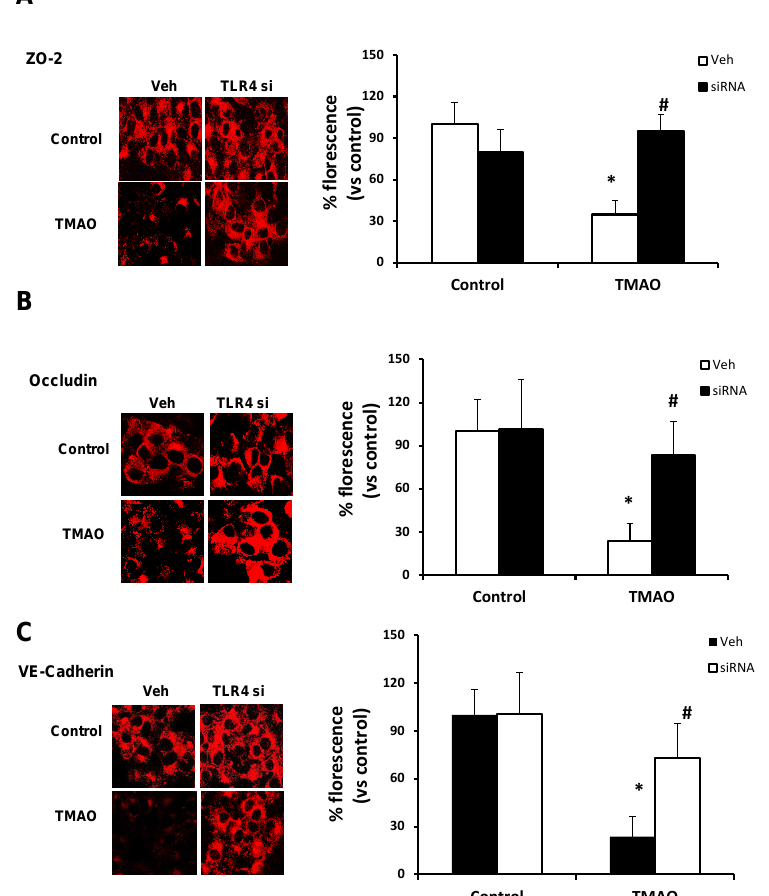
Figure 8. E ff ects of TLR4 inhibition by TLR4 siRNA on TMAO-induced tight junction proteins ZO-2, Occludin, and VE-Cadherin in EOMAs. Representative confocal analysis shows the ZO-2 ( A ), Occludin ( B ), and VE-Cadherin ( C ) expression in EOMAs with or without stimulation of TMAO and / or HMGB1 inhibition by glycyrrhizin. n = 5. Veh: vehicle. * significant di ff erence from control, # significant di ff erence from